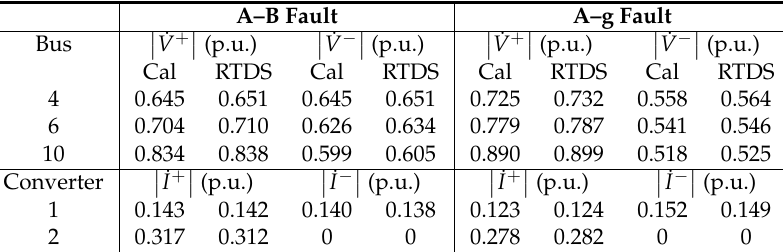
Table 5. Comparison between calculations and simulations